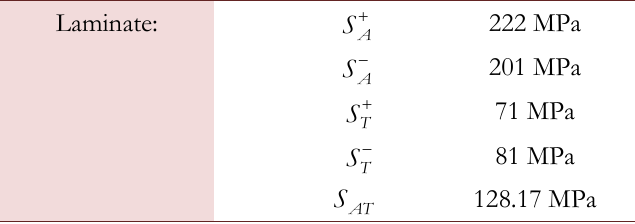
Table 2: Mechanical strength of the GFRP laminate